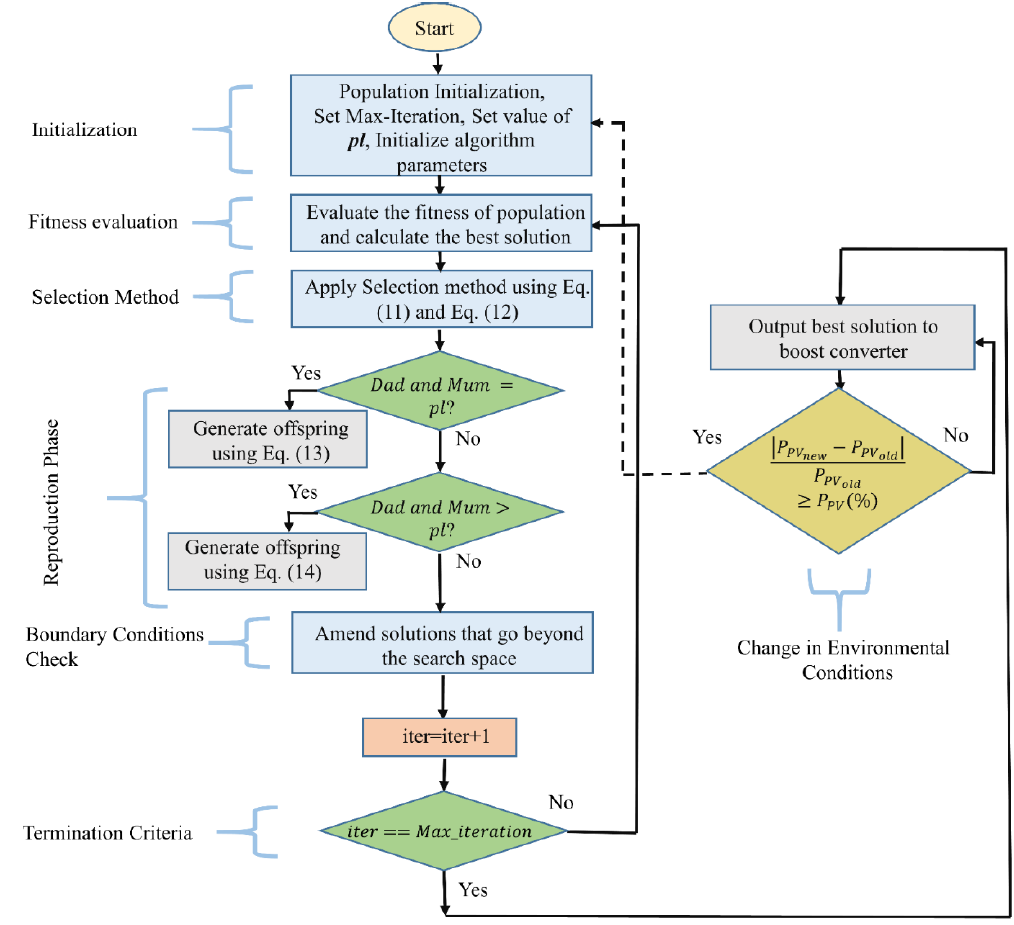
Figure 5. BMO-based MPPT control flow chart.